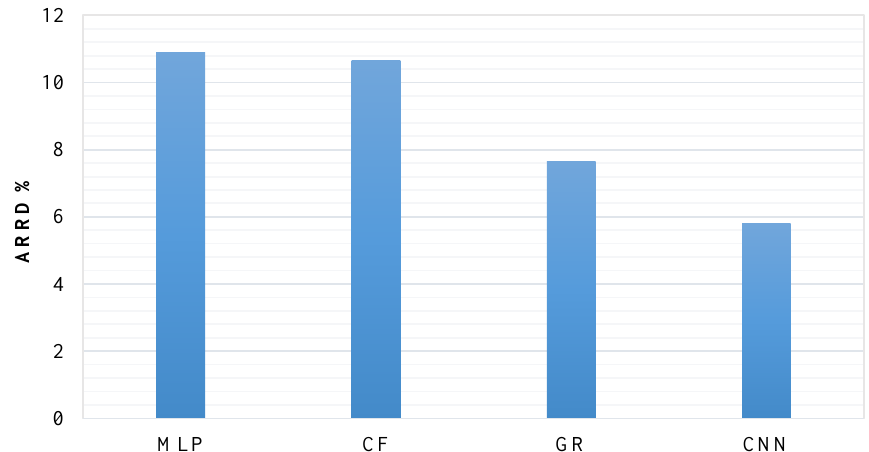
Figure 6. Evaluation between predicted values of three artificial neural network models and committee neural network.